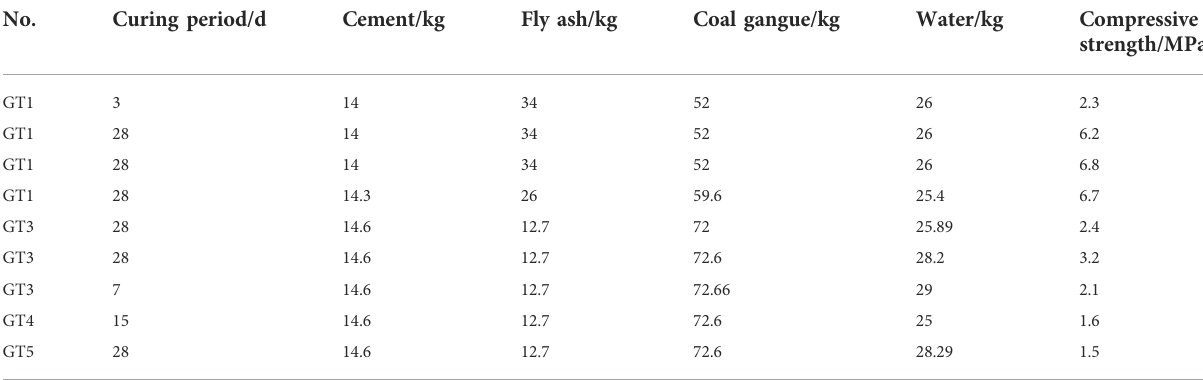
TABLE 3 Uniaxial compression test results for different ratios of the back fi ll body over the ground.